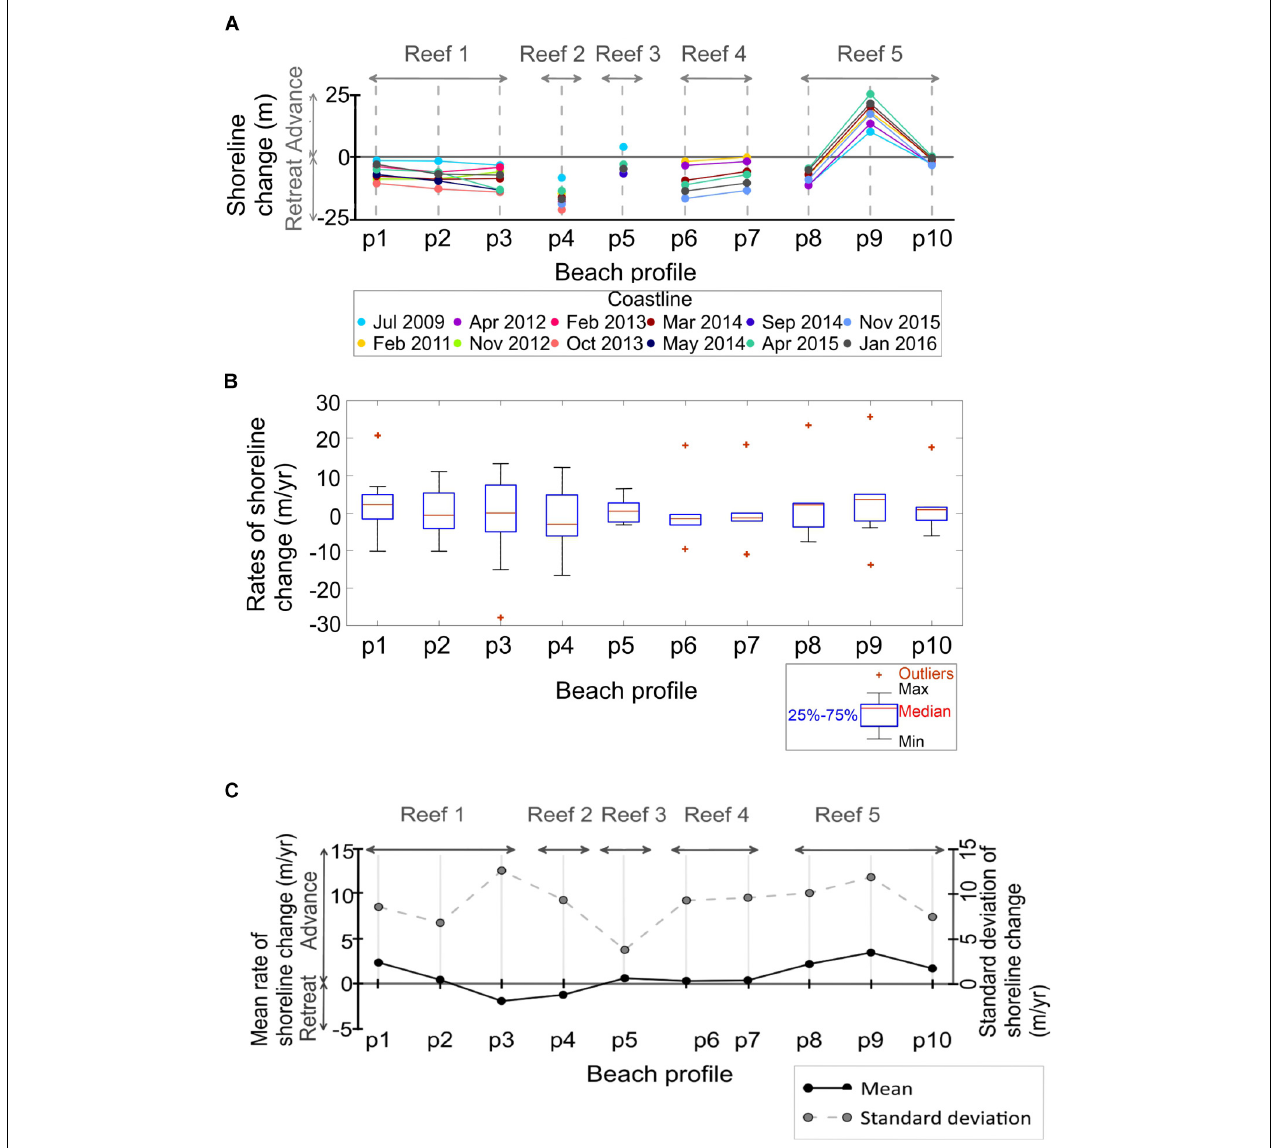
FIGURE 6 | Shoreline evolution 2006–2016 for the ten reef-beach profiles selected: (A) Shoreline change from 2006. (B) Boxplot of rates of shoreline change. (C) Mean and standard deviation values of the rates of shoreline change.